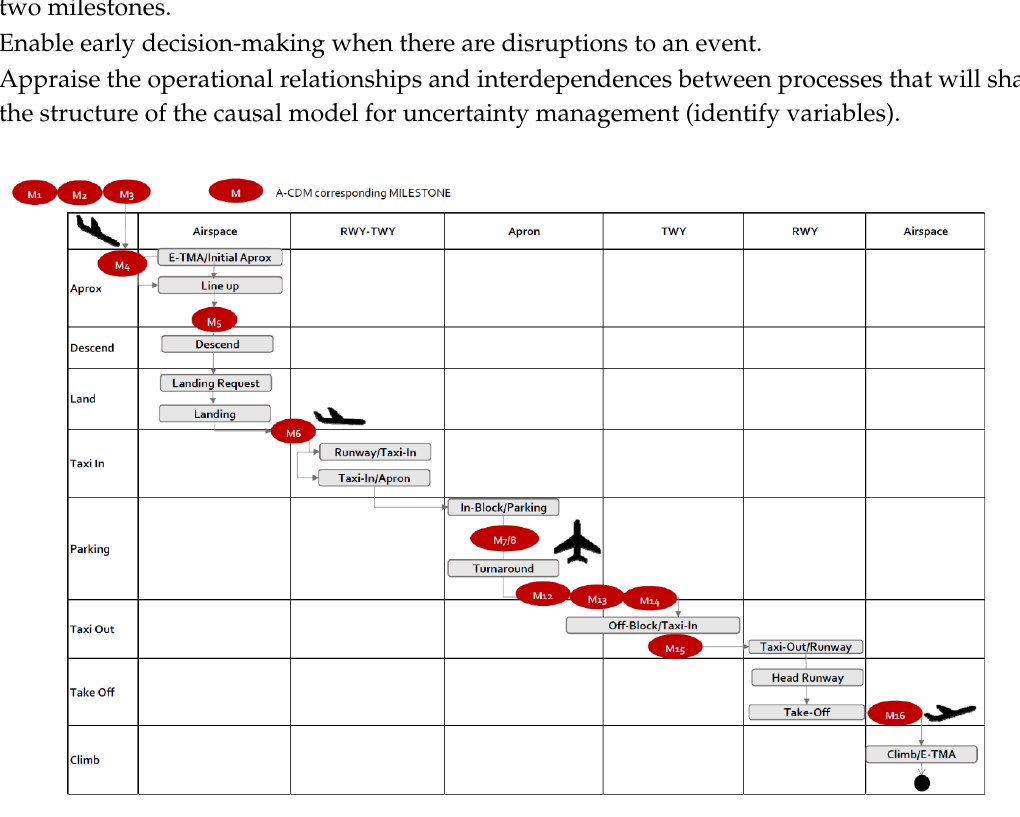
Figure 5. Combination of the BMP for the airport–airspace integrated operations and the A-CDM concept.